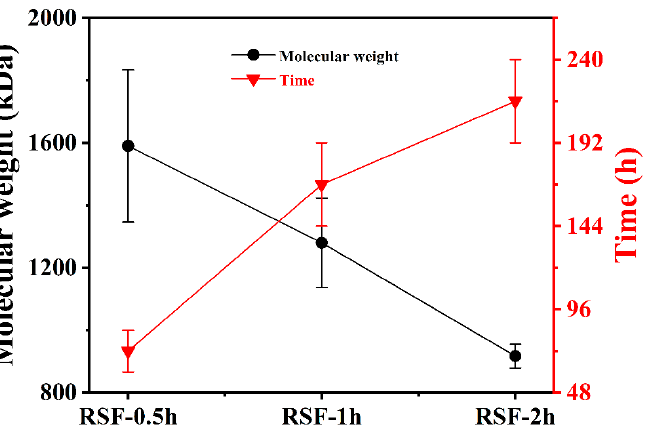
Figure 1. Molecular weights and gelation times of silk fibroin under different degumming times. The silk fibroin extracted under the degumming times of 0.5, 1, and 2 h were named RSF-0.5h, RSF-1h, and RSF-2h, respectively.